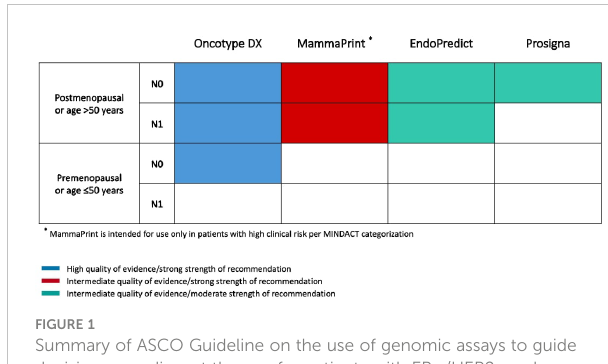
FIGURE 1 Summary of ASCO Guideline on the use of genomic assays to guide decisions on adjuvant therapy for patients with ER+/HER2- early breast